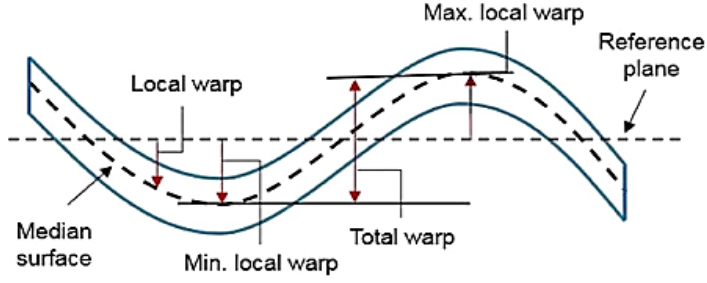
Figure 1. Illustration of the warping measurement method [3].